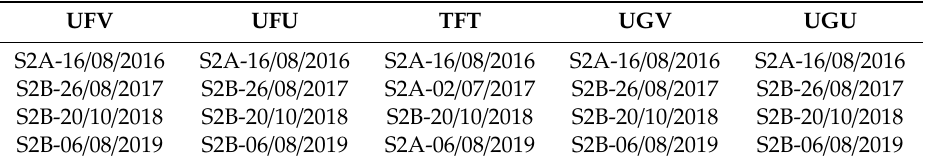
Table 1. Sentinel image acquisition dates. S2A: Sentinel-2A; S2B: